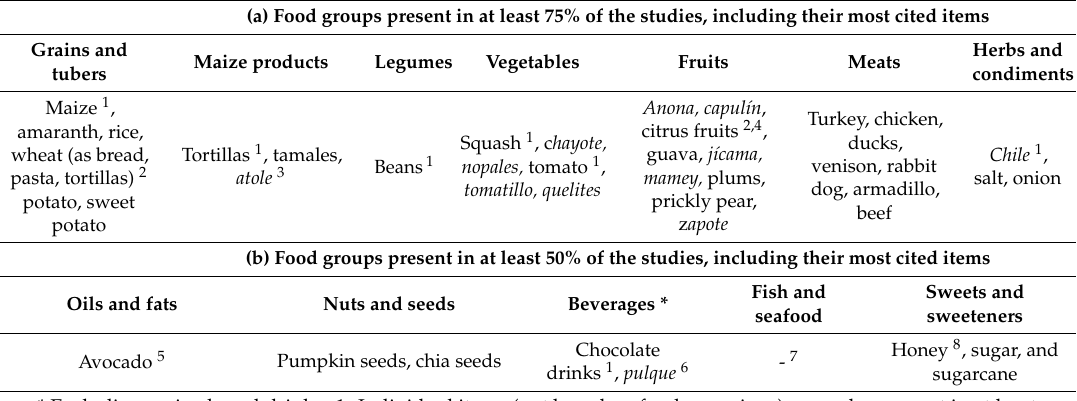
Table 2. Most cited items and food groups present in all included studies.( n =